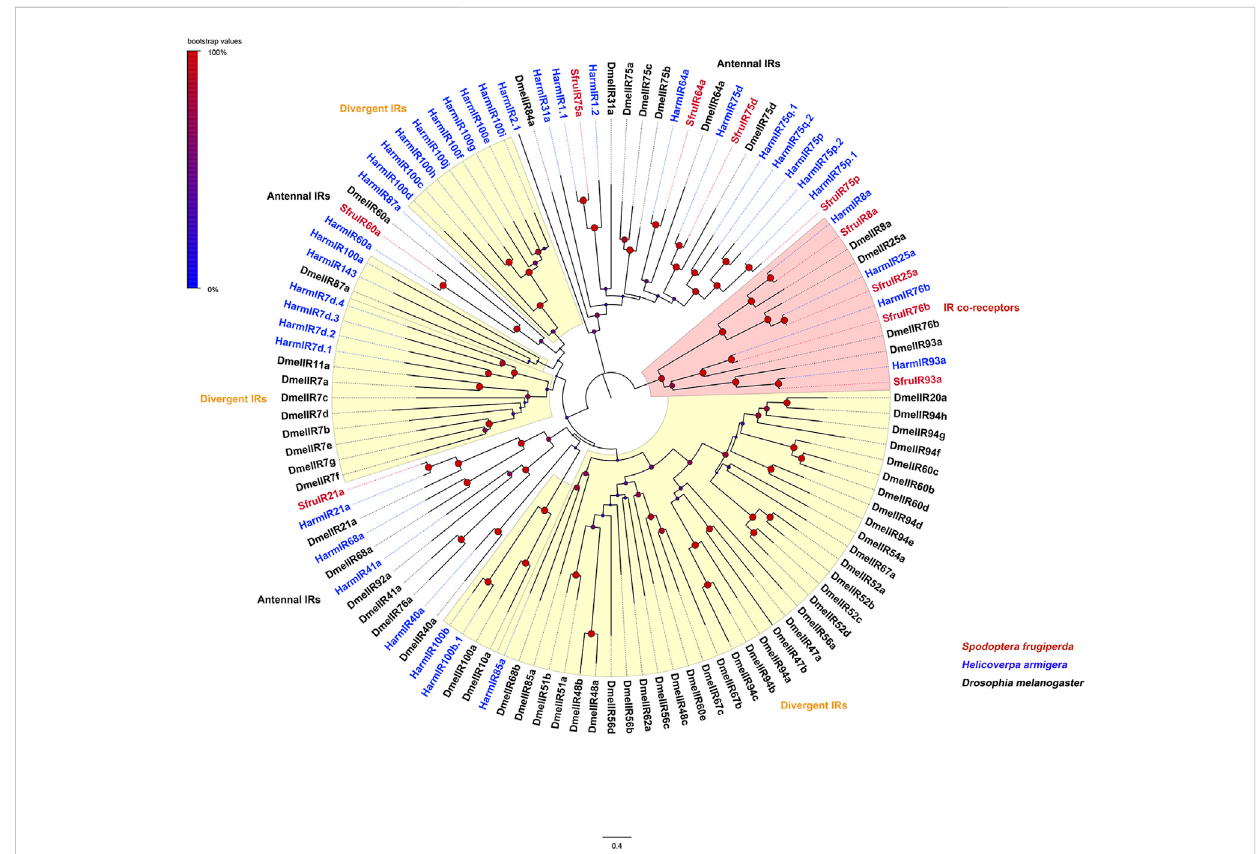
FIGURE 3 Neighbor-joining tree constructed with candidate IRs from S. frugiperda and homologs from B . mori and D . melanogaster . The tree was rooted by theIR-coreceptororthologs.Nodesupportwasestimatedwith1000bootstrapreplicates,andbootstrapvaluesweredisplayedwithcirclesbasedonthe scale indicated at the top left. The scale bar at the bottom indicates the branch length in proportion to amino acid substitutions per